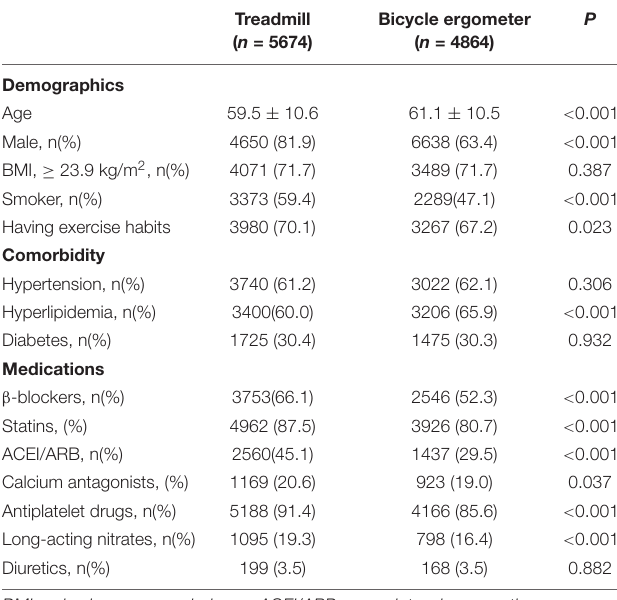
TABLE 1 | Comparison of baseline characteristics between the treadmill group and the bicycle ergometer